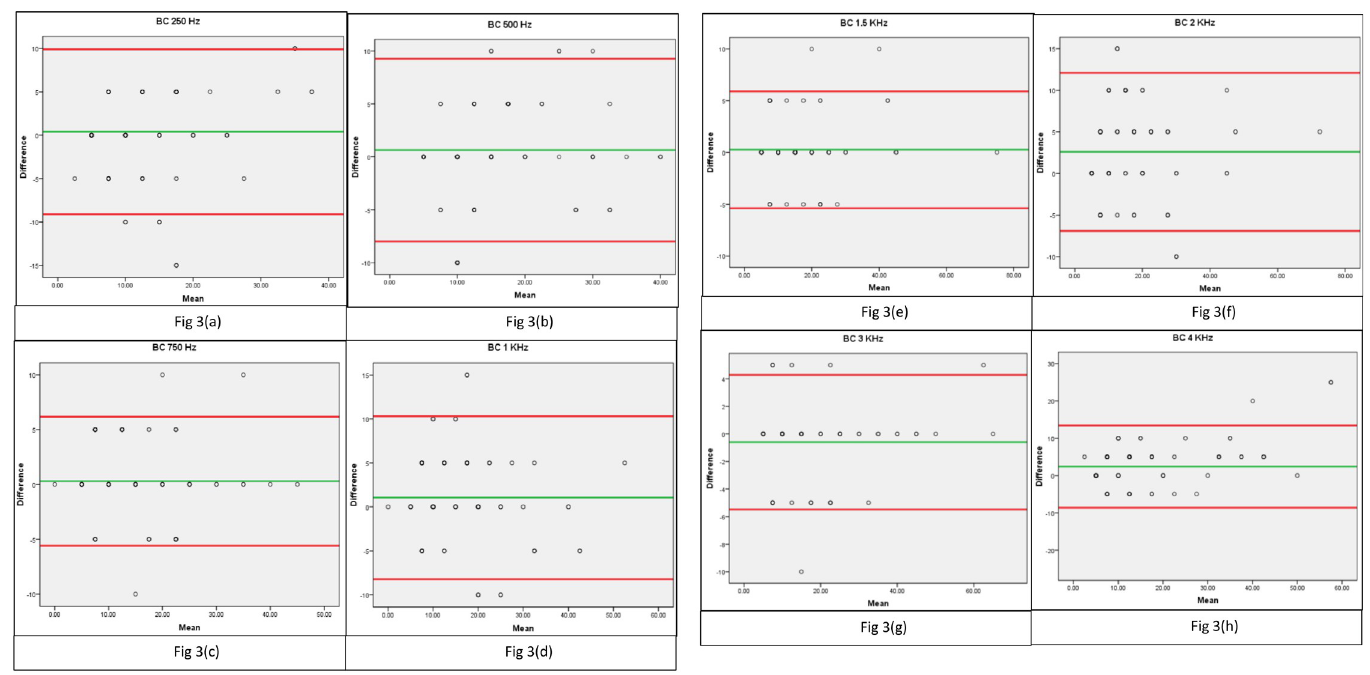
Fig 3. (A-H): Bland Altman plots showing difference against mean for bone conduction thresholds across frequencies between gold standard and HEARZAP audiometry.